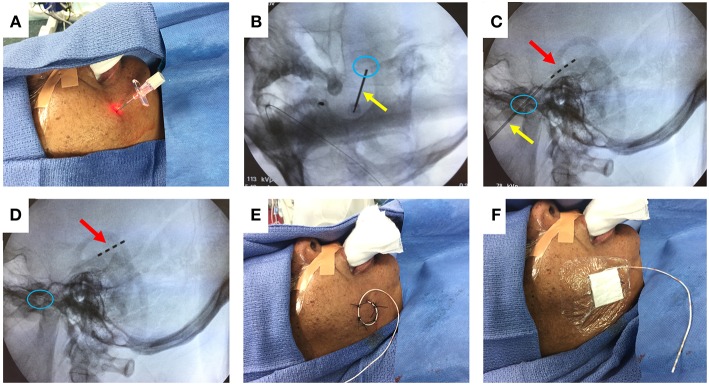
FO electrode placement procedure. (A) Introducer needle inserted through cheek skin. (B) Fluoroscopy image (oblique view) showing needle (yellow arrow) passing through the foramen ovale (blue circle). (C) Fluoroscopy image (lateral view) showing advancement of 4-contact FO electrode (red arrow) past the needle tip. (D) Fluoroscopy image (lateral view) showing removal of the needle, leaving the FO electrode in place. (E) Sutures securing the FO electrode to the cheek. (F) Sterile dressing placed over the FO electrode. Written informed consent for the use of these images was obtained from the individual shown in the images.